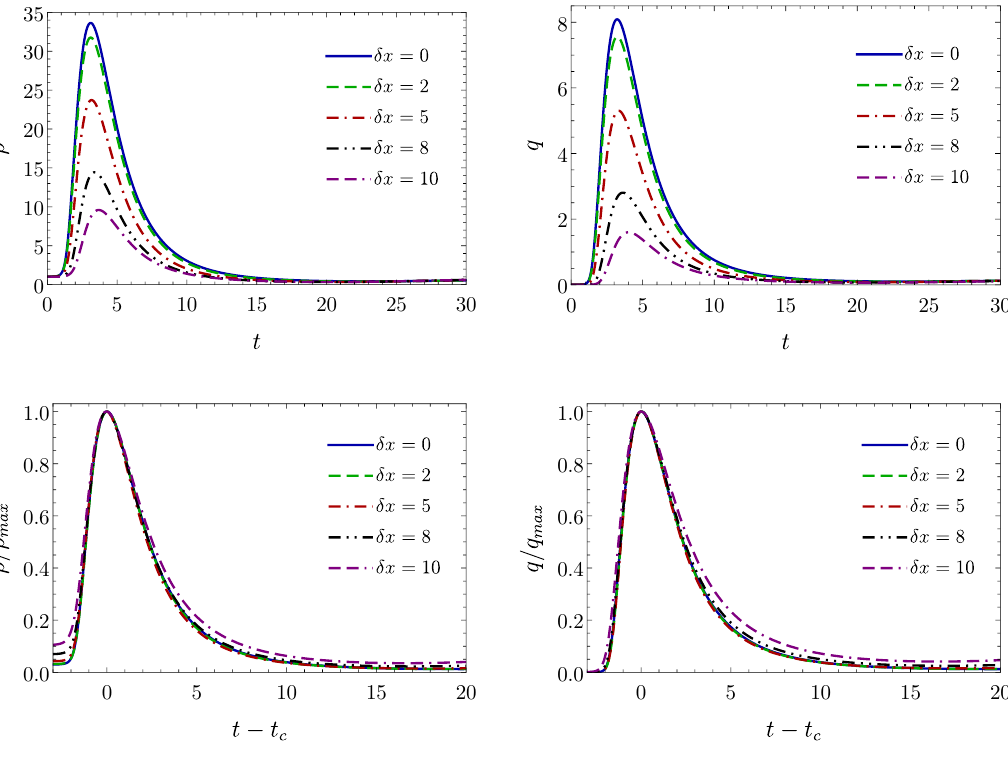
Figure 5 . Top: mass and charge densities at the origin as a function of time for charged oblate collisions with different impact parameters. Bottom: mass and charge densities normalized by their the maximum, as a function of the elapsed time since the